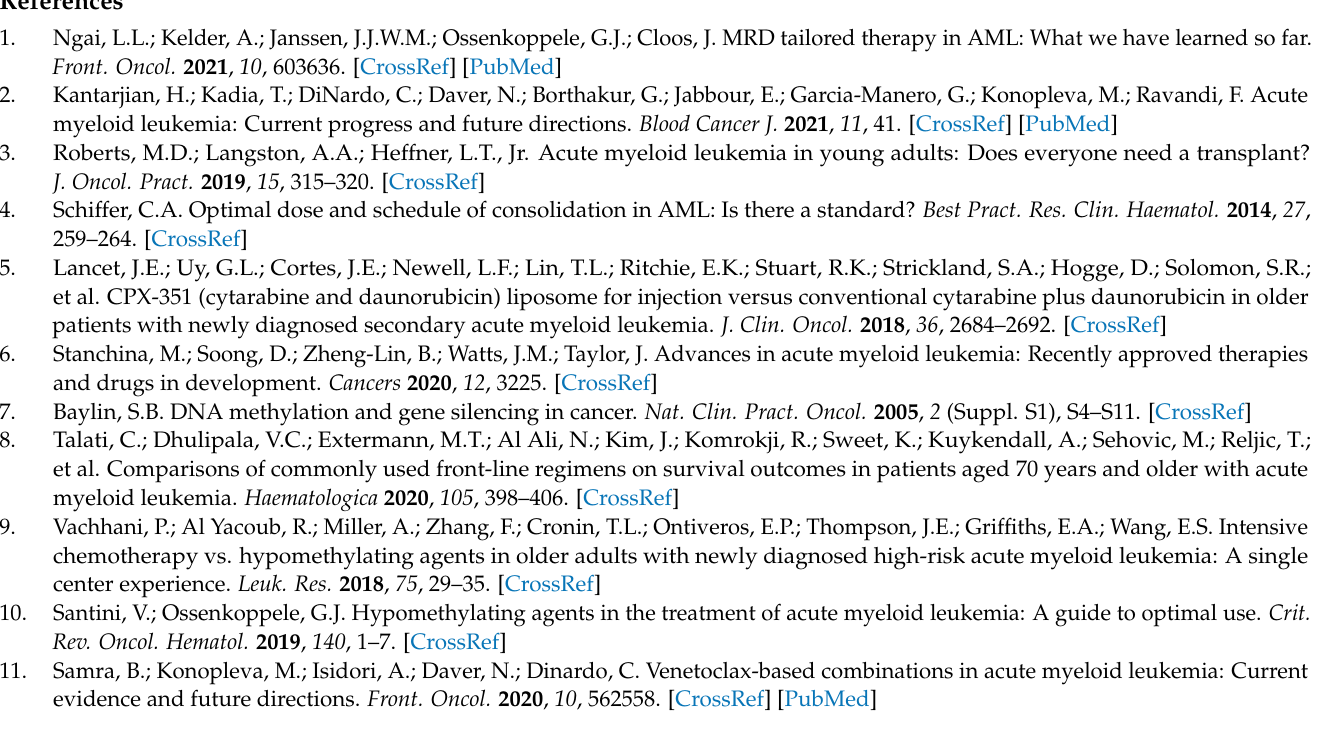
Table S2: Antibody